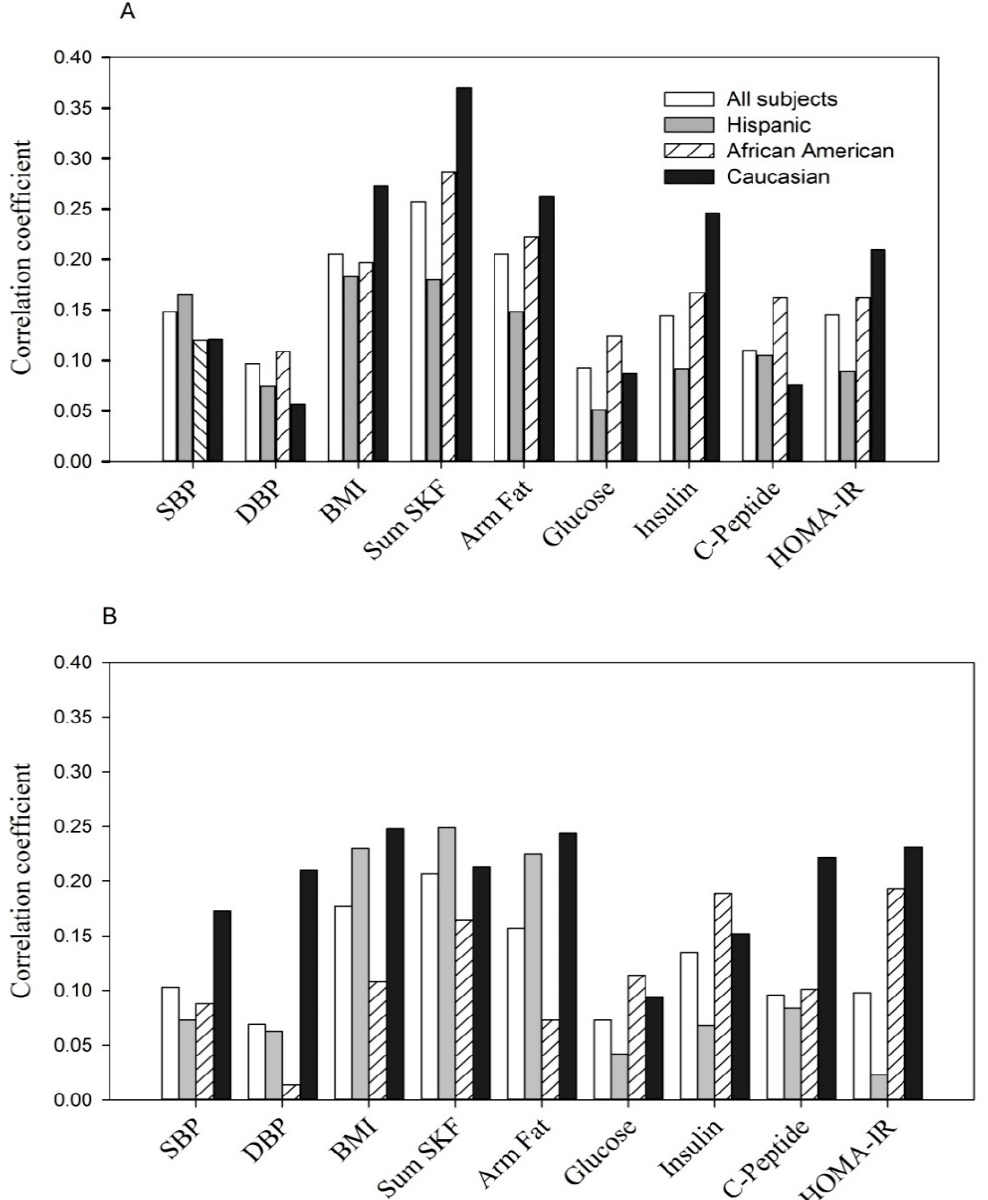
Figure 3. ( A , at entry; B , during the 3rd trimester). The relationship of variable combined low adiponectin (lowest tertile) with high resistin (highest tertile) to anthropometric and glycemic parameters.